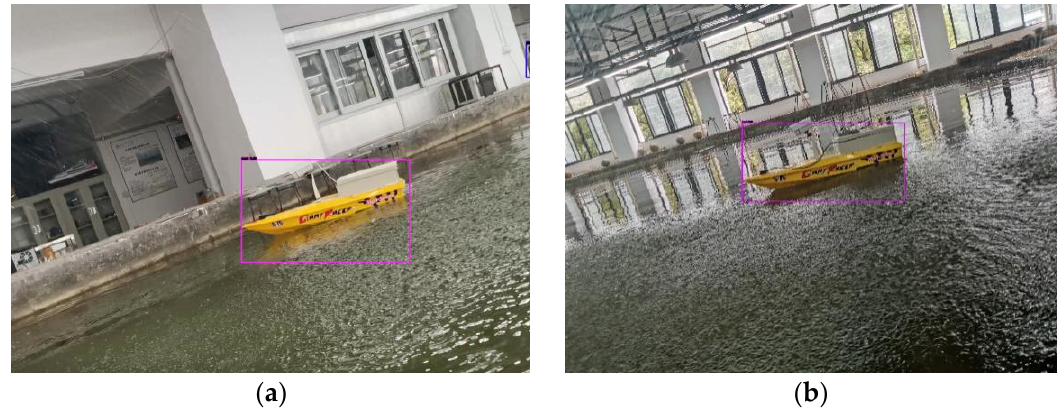
Figure 10. Target detection results of tilted images in experimental pool. ( a ) Tilted images 1 in experimental pool. ( b ) Tilted images 2 in experimental